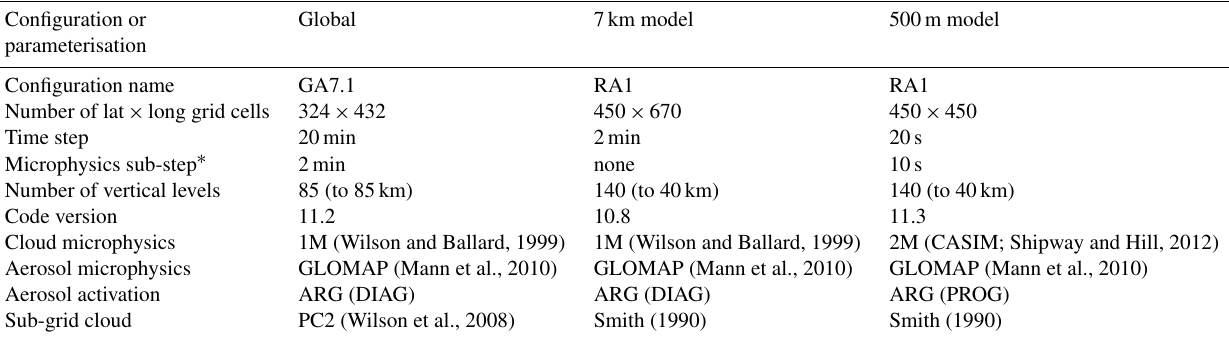
Table 1. Summary of differences between model configurations used. Unless explicitly mentioned, affected by recent minor updates or dictated by the name of the model configuration as described in the appropriate documentation paper, the code for global and regional simulations is identical. In the “Cloud microphysics” row, 1M signifies a single-moment scheme and 2M a double-moment scheme. In the “Aerosol activation” row, ARG stands for the parameterisation of Abdul-Razzak and Ghan (2000). This parameterisation has two im- plementations, labelled DIAG when cloud droplet number concentration is diagnostic and PROG when it is prognostic. The microphysics sub-step is marked with an asterisk, because we wish to emphasise that the sub-step is not applied to condensation or evaporation, which are treated by the cloud parameterisation and not by the microphysics scheme. However, it does apply to precipitation-related processes such as autoconversion and accretion, for